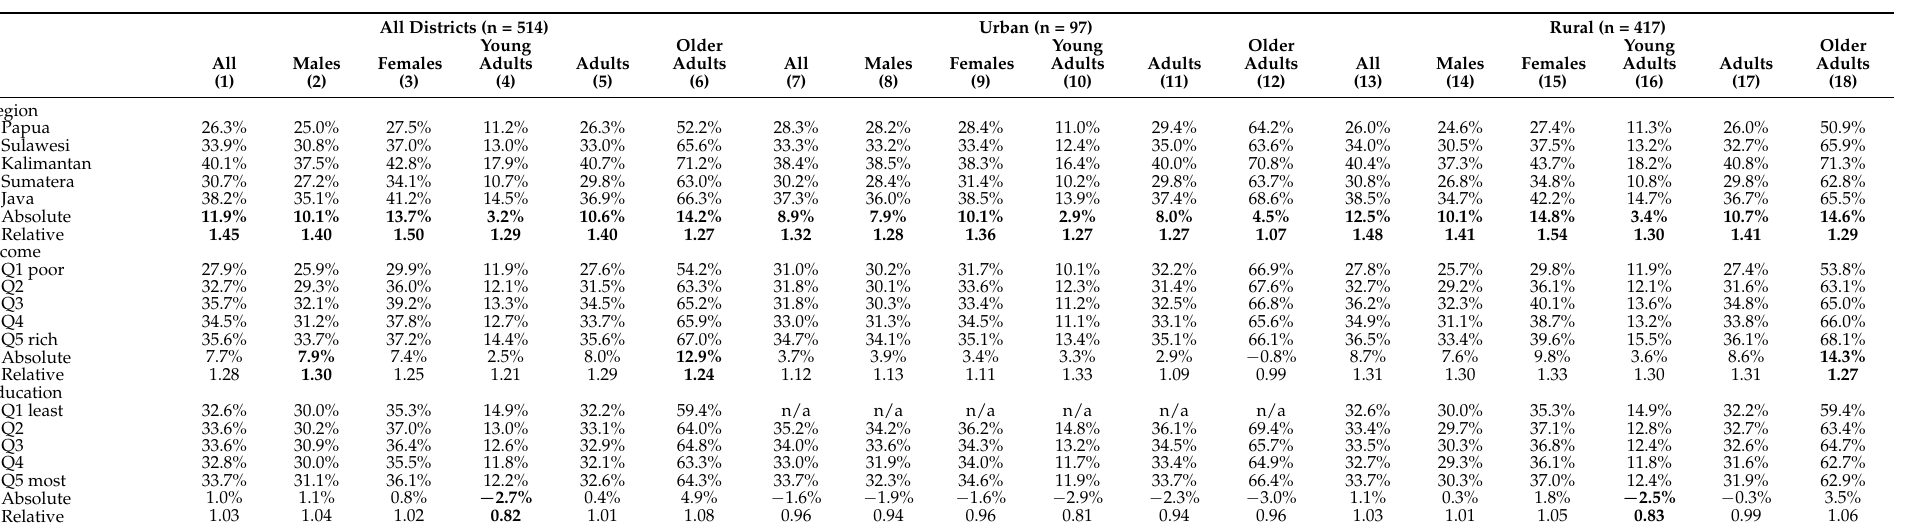
Table 3. Geographic and socioeconomic disparity in hypertension among